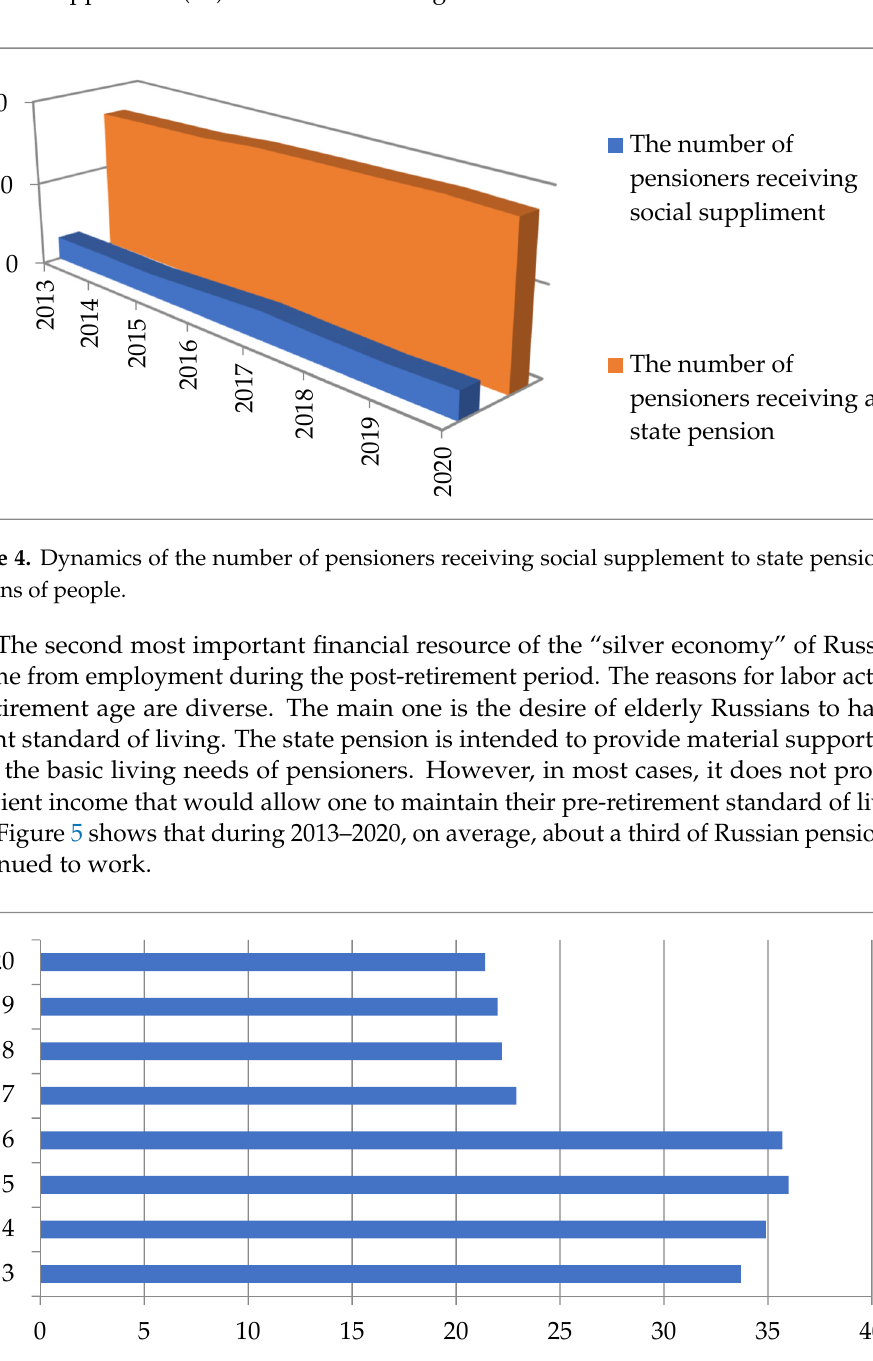
Figure 3. Dynamics of the average size of the state pension and the subsistence minimum of a pensioner in Russia, thousand rubles.